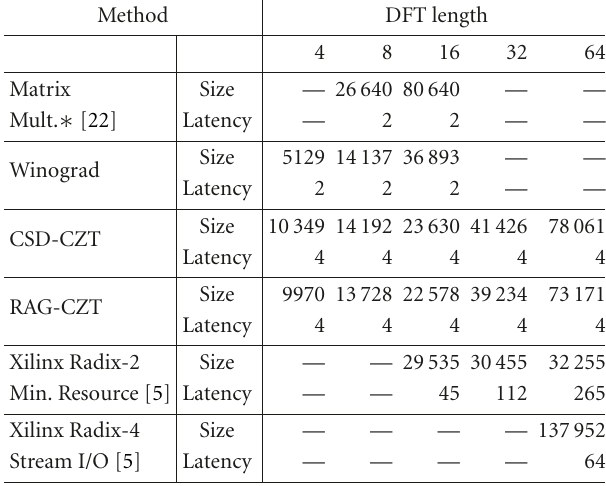
Table 4: Size (measured via equivalent number of gates for com- binational and noncombinational elements) and speed as latency (measured as clock cycles until first output value are available) for di ff erent DFT lengths sorted by